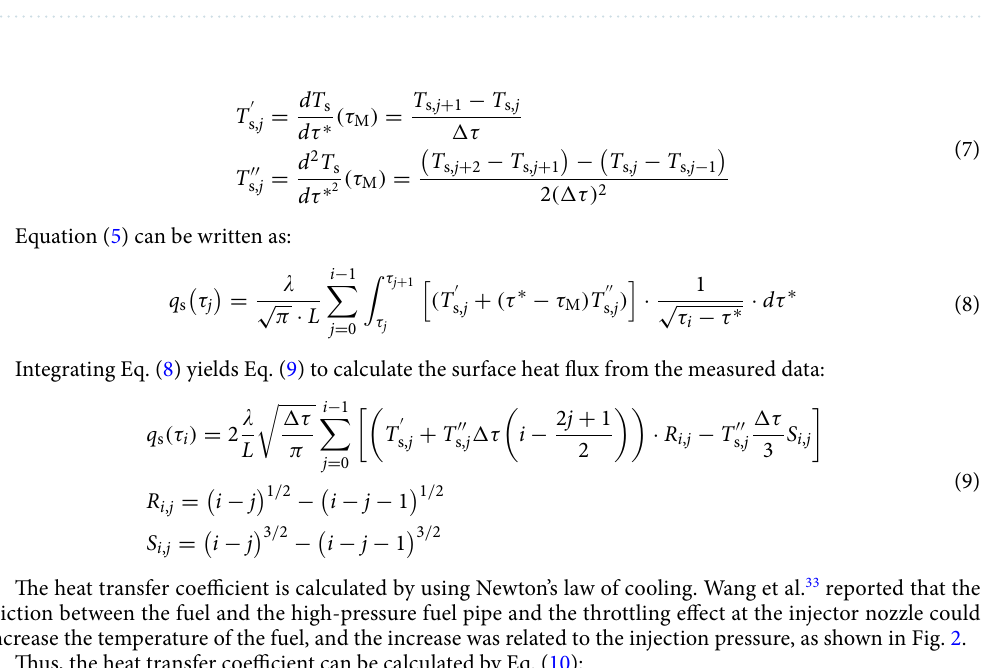
Figure 2. Injection temperature at the injector nozzle under different injection